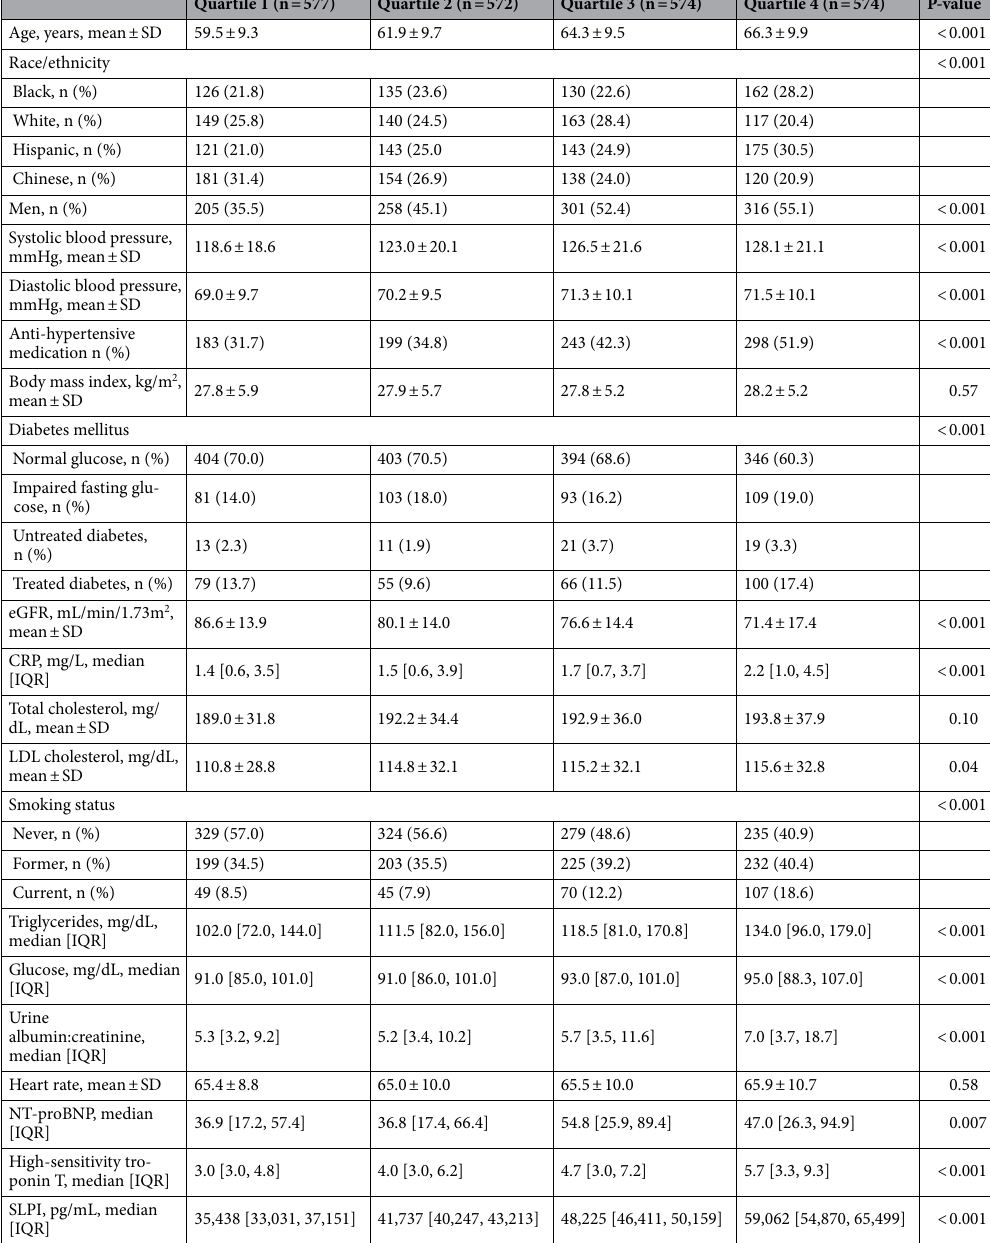
Table 1. Participant characteristics at baseline (examination 2) by quartile of serum SLPI. eGFR estimated glomerular filtration rate, HDL high-density lipoprotein, LDL low-density lipoprotein, NT-proBNP N-terminal-pro brain natriuretic peptide, SLPI secretory leukocyte protease